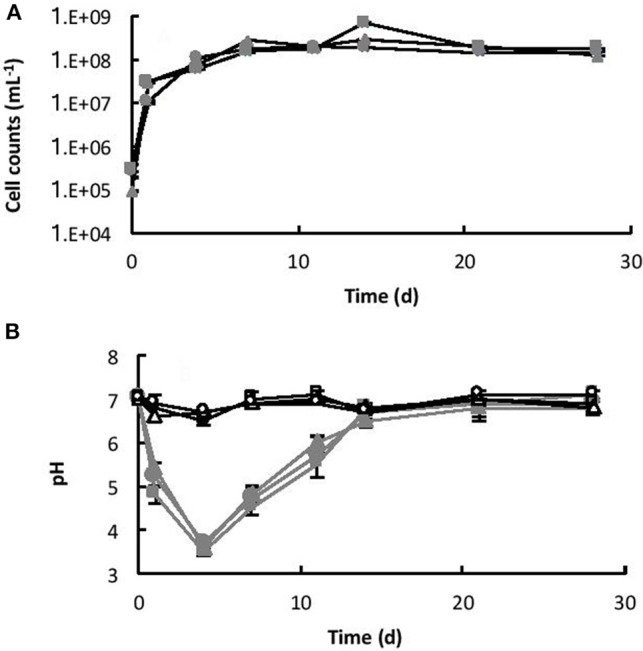
(A) Growth of Burkholderia sp. strain B_33 in a minimal medium with basalt as the sole source of bio-essential elements. (B) Change in pH of the medium over time. The values reported are the means of three independent biotic [B1 (), B2 (), B3 ()] and abiotic [C1 (□), C2 (△), C3 (○)] experiments, and the standard error associated with these determinations is shown. Cell counts demonstrated that there was no bacterial contamination in the abiotic controls after 28 days.